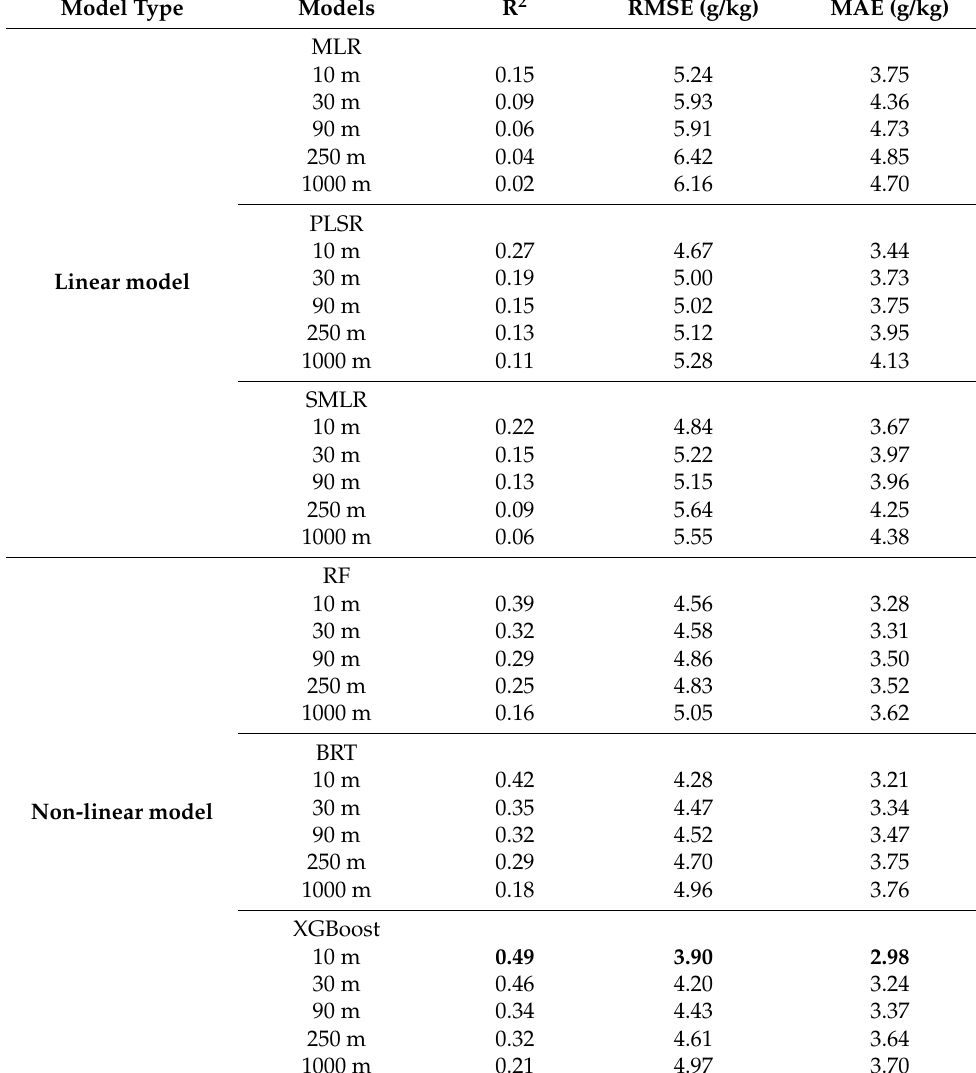
Table 6. The performance of six modeling techniques at different spatial resolutions for SOC predic- tion using validation data. The most accurate result is shown in